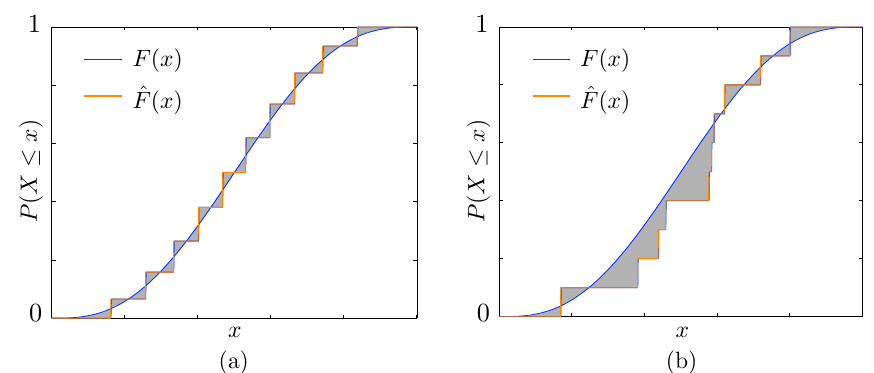
Fig. 2. Continuous and discrete cumulative distribution functions.